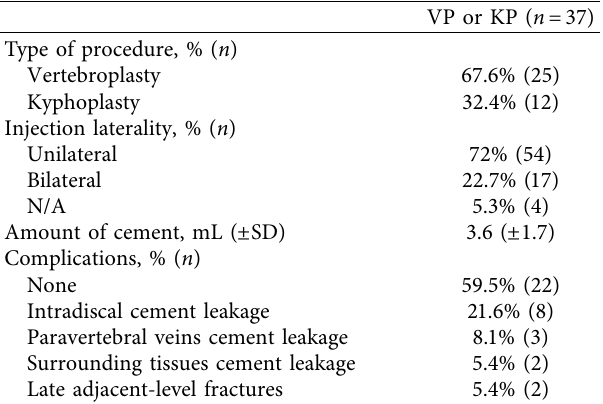
Table 2: Technique and complications of VBA.